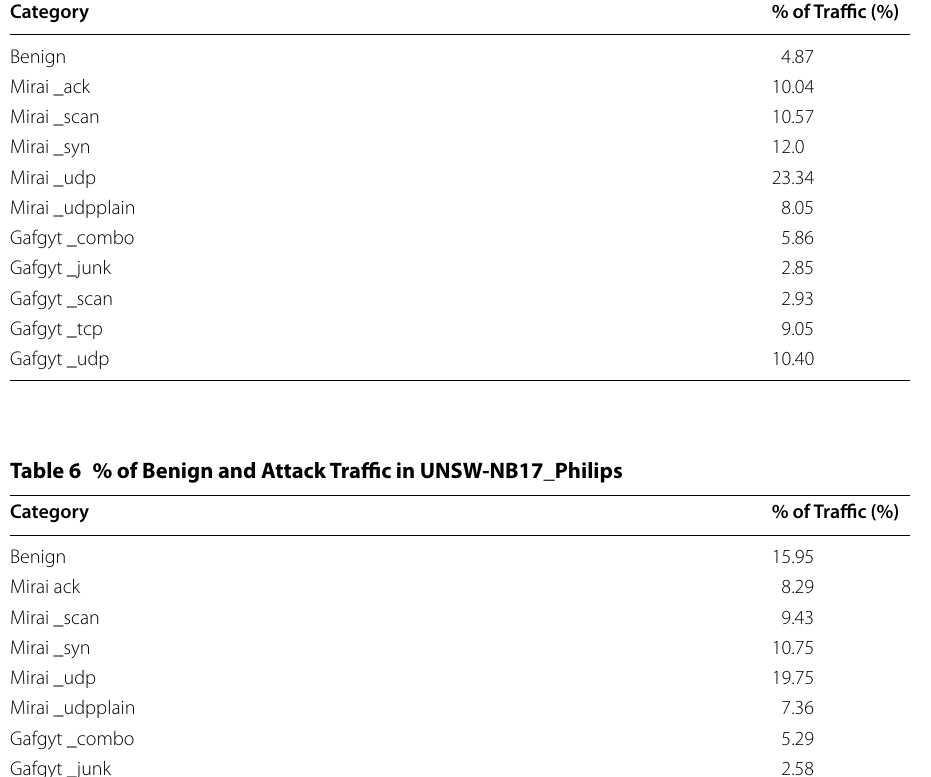
Table 5 % of benign and attack traffic in UNSW-NB17_Doorbell Category